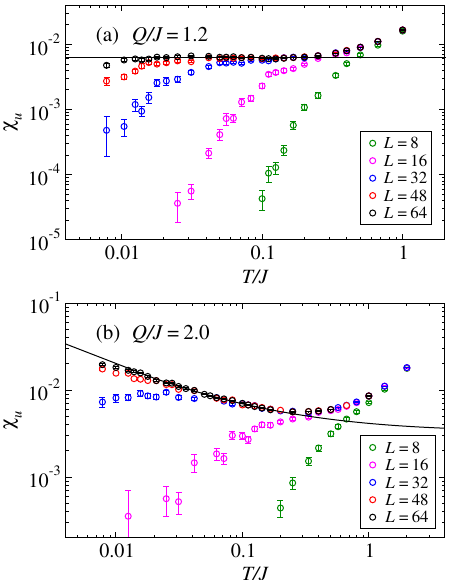
FIG. 19. Temperature dependence of the uniform susceptibility of the random- Q model for several different system sizes. (a) shows results at Q=J ¼ 1 . 2 , which is within the error bars of the estimated AFM-RS critical point (Fig. 11), while the system in (b) is inside the RS phase at Q=J ¼ 2 . The horizontal line in (a) corresponds to the scaling expected if the dynamic exponent z ¼ 2 . The curve in (b) shows a fit of the L ¼ 64 data to c þ bT − a with the exponent a ¼ 0 . 60 (cid:2) 0 . 08 the form χ u ¼ corresponding to z ¼ 2 = ð 1 − a Þ ≈ 5 .